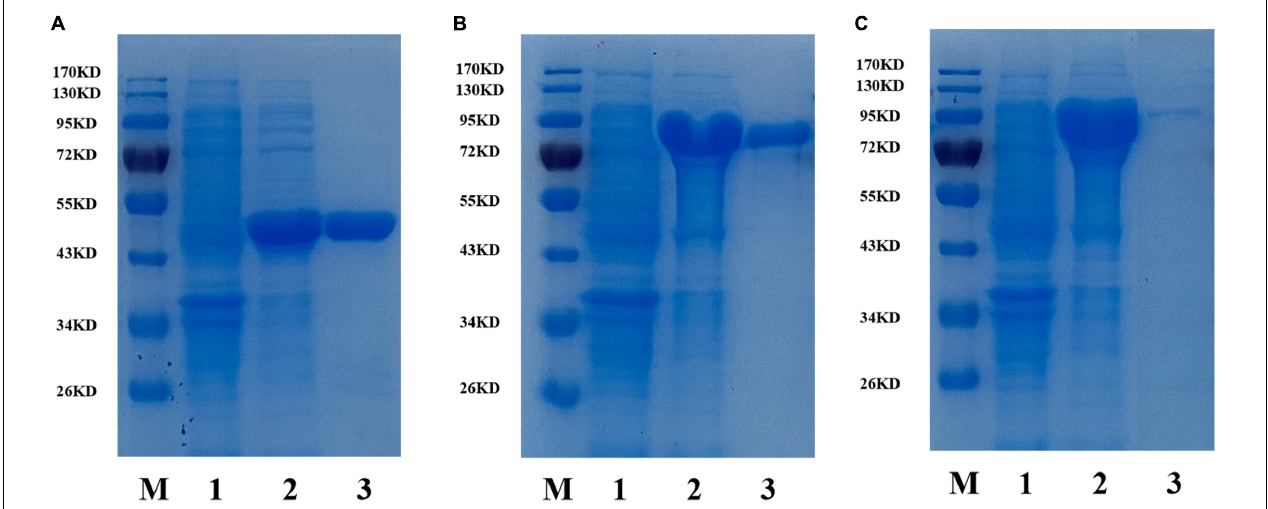
FIGURE 1 | SDS-PAGE analysis of recombinant BaBgl1A (A) , BaBgl3A (B) , and BaBgl3B (C) . Lane M, protein markers; lane 1, culture lysate of recombinant β -glucosidases before isopropyl β -D-1-thiogalactopyranoside (IPTG) induction; lane 2, culture lysate of recombinant β -glucosidases after IPTG induction; lane 3,